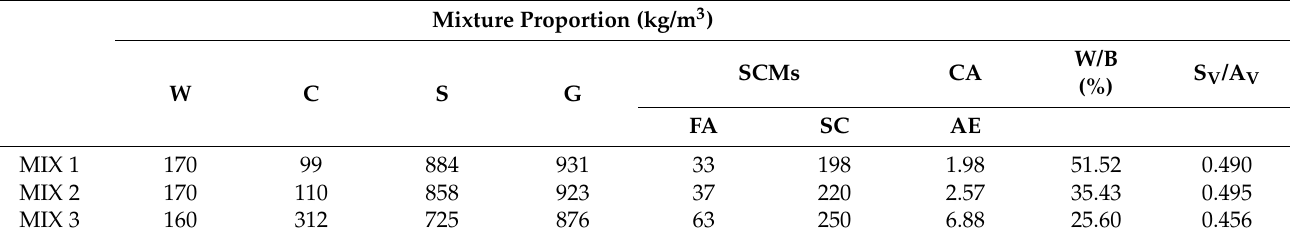
Table 2. Concrete mixture proportions of the concrete cylinders used in this study.